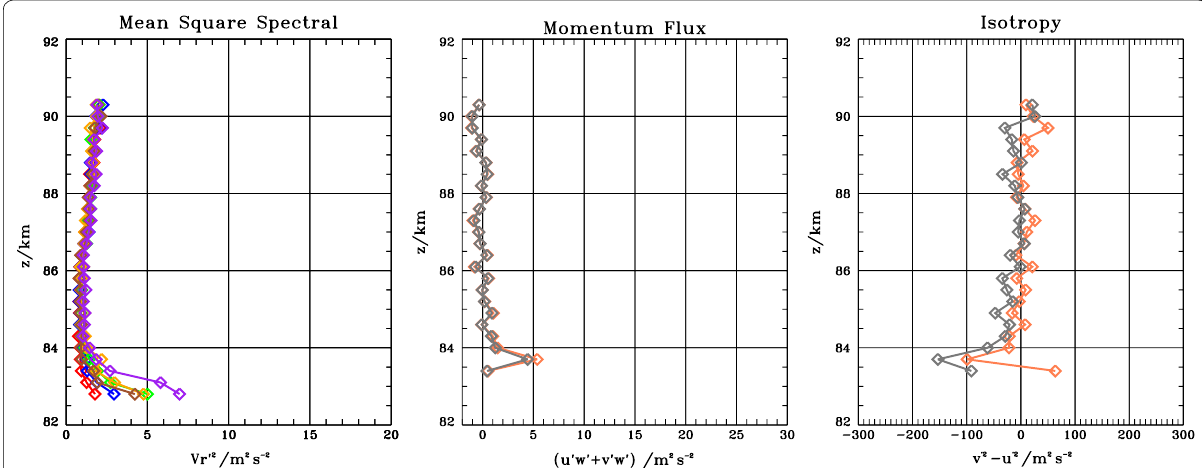
Fig. 8 Subscale mean square radial velocities (left), momentum fluxes (centre) and isotropies (right) for periods less than 12.8 h. The colours for the radial velocities are V, red, NW blue, N green, NE orange, SW brown, and W purple. Note that the isotropy scale is different from that in Fig. 9. Values of the subscale flux vary about zero with height, and are essential zero, as are those for the